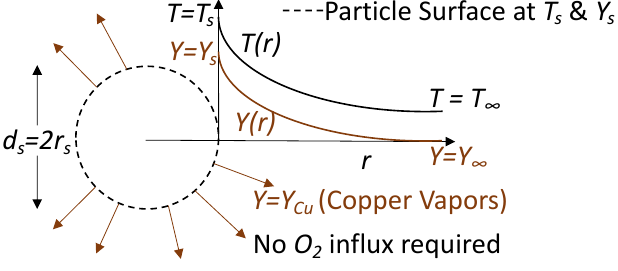
Figure 2. Combustion of a single solid nanothermite; surface denotes nanothermite pellet surface. This combustion of a single-particle behaves the same as a highly concentrated group combustion event (sheath combustion as discussed in Section